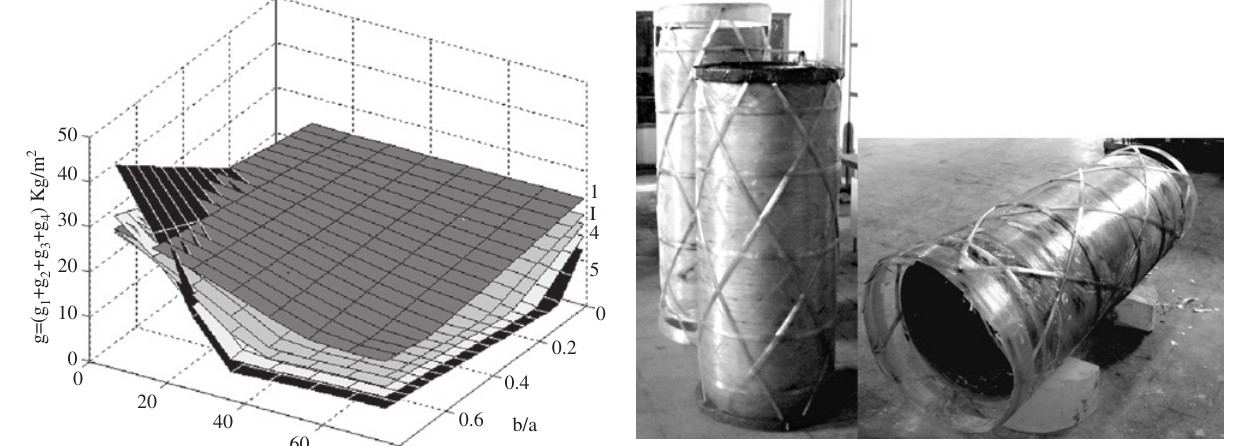
Figure 11 Three experimental stiffened composite pressure vessels.